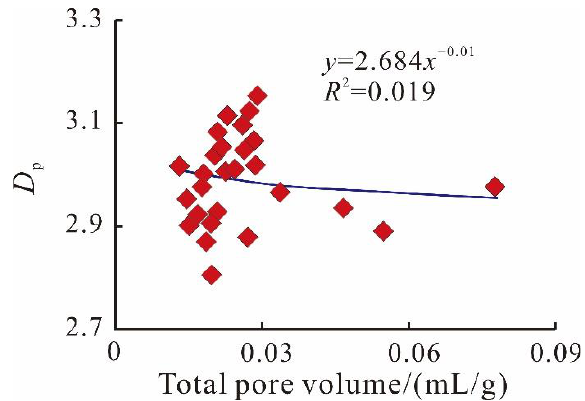
Figure 9. Relationship between total pore volume and percolation fractal dimension ( D p ).